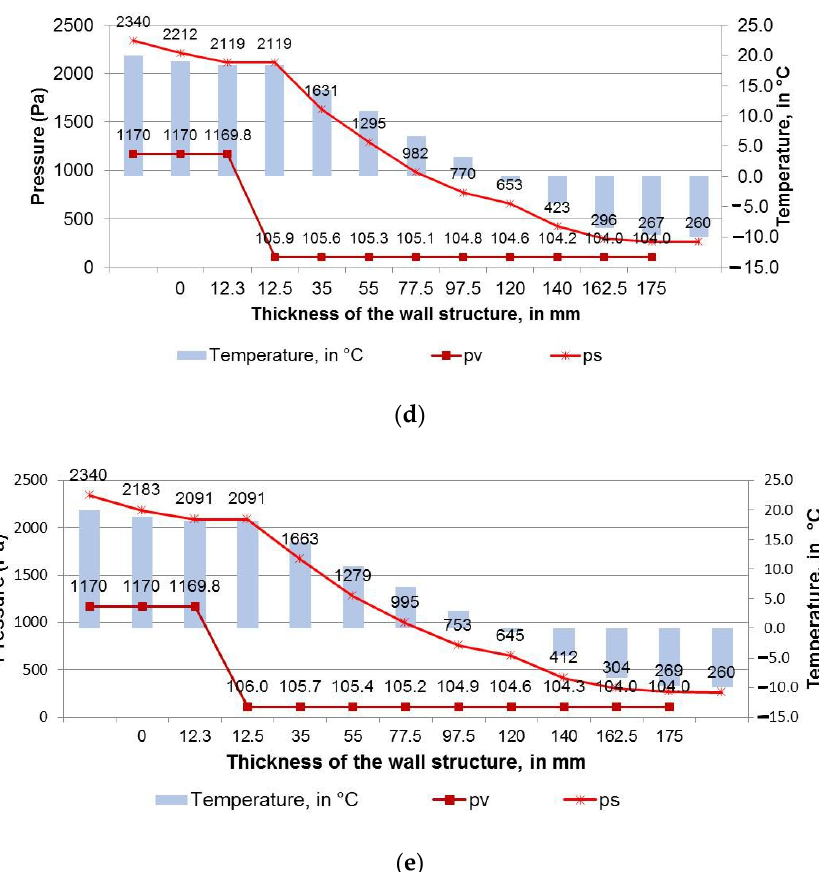
Figure 8. Graphic example of the variation of the partial pressure (p v ) and the saturation pressure (p s ) for the experimental structures with the following fillers: ( a ) wood fibers; ( b ) ground paper; ( c ) wool; ( d ) ABS waste; ( e ) reed.